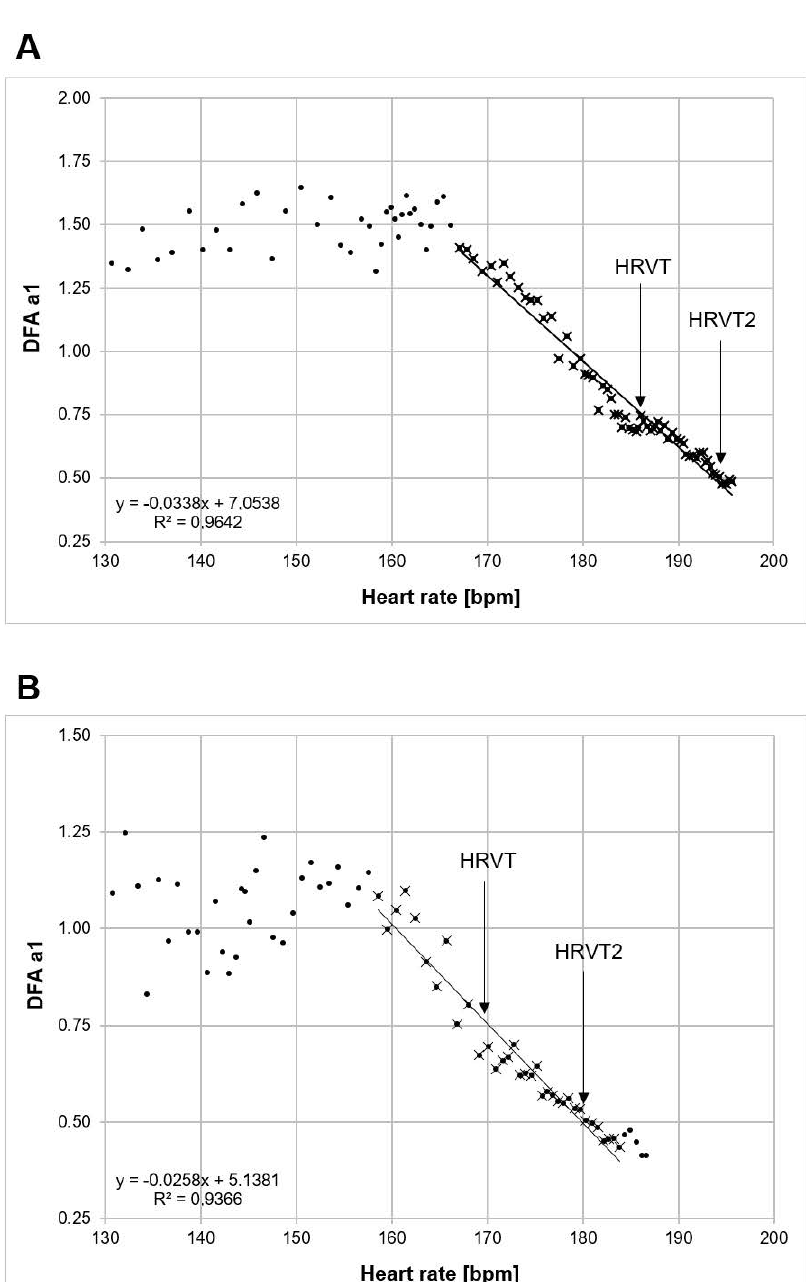
Figure 1. Individual examples of calculation methods for both HRVT and HRVT2. A line is drawn through the straight section of the plot of DFA a1 vs. HR. HRVT is at the intersection of DFA a1 = 0.75 and HRVT2 is at the intersection of DFA a1 = 0.5. ( A ) Participant with a VO 2MAX of 72 mL/kg/min, VT2 at 192 bpm and HRVT2 at 194 bpm. ( B ) Participant with a VO 2MAX of 58 mL/kg/min, VT2 at 179 bpm and HRVT2 at 180 bpm. Points with X are used for linear